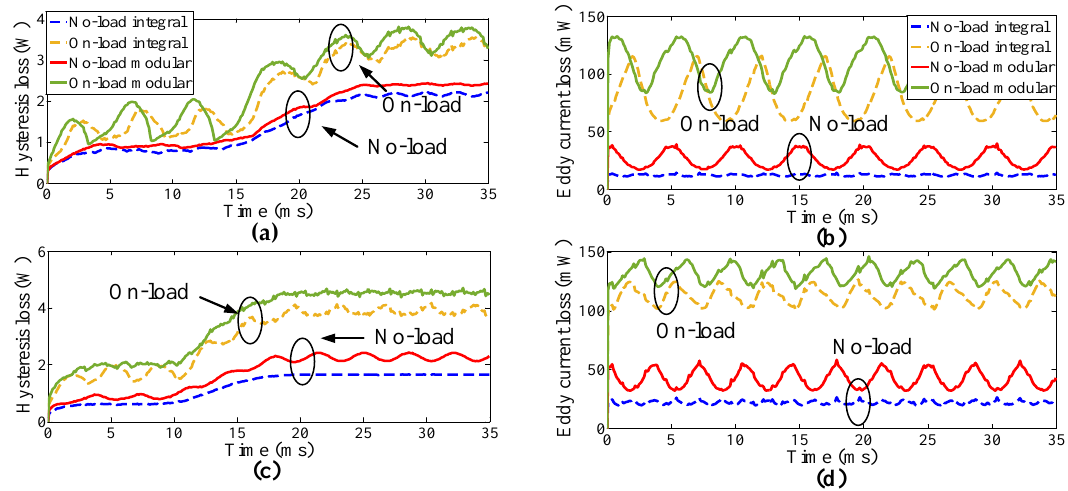
/ 10p; ( b ) 12s / 10p; ( c ) 12s / 14p; ( d ) 12s / 14p.